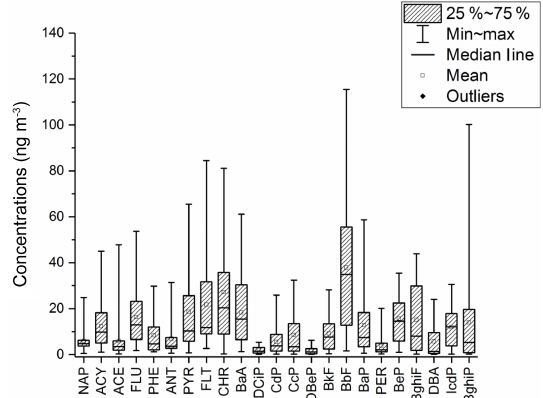
Figure 3. The distribution of concentrations of PAHs (shaded bars; 25% – first quartile; 75% – third quartile).